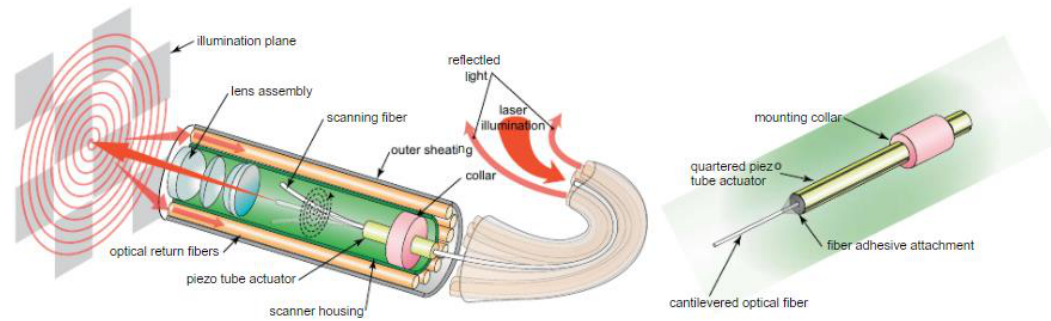
Figure 17. Schematic diagram of scanning fiber endoscope (SFE), and the schematic of the actuator used (taken with the permission of [3]).